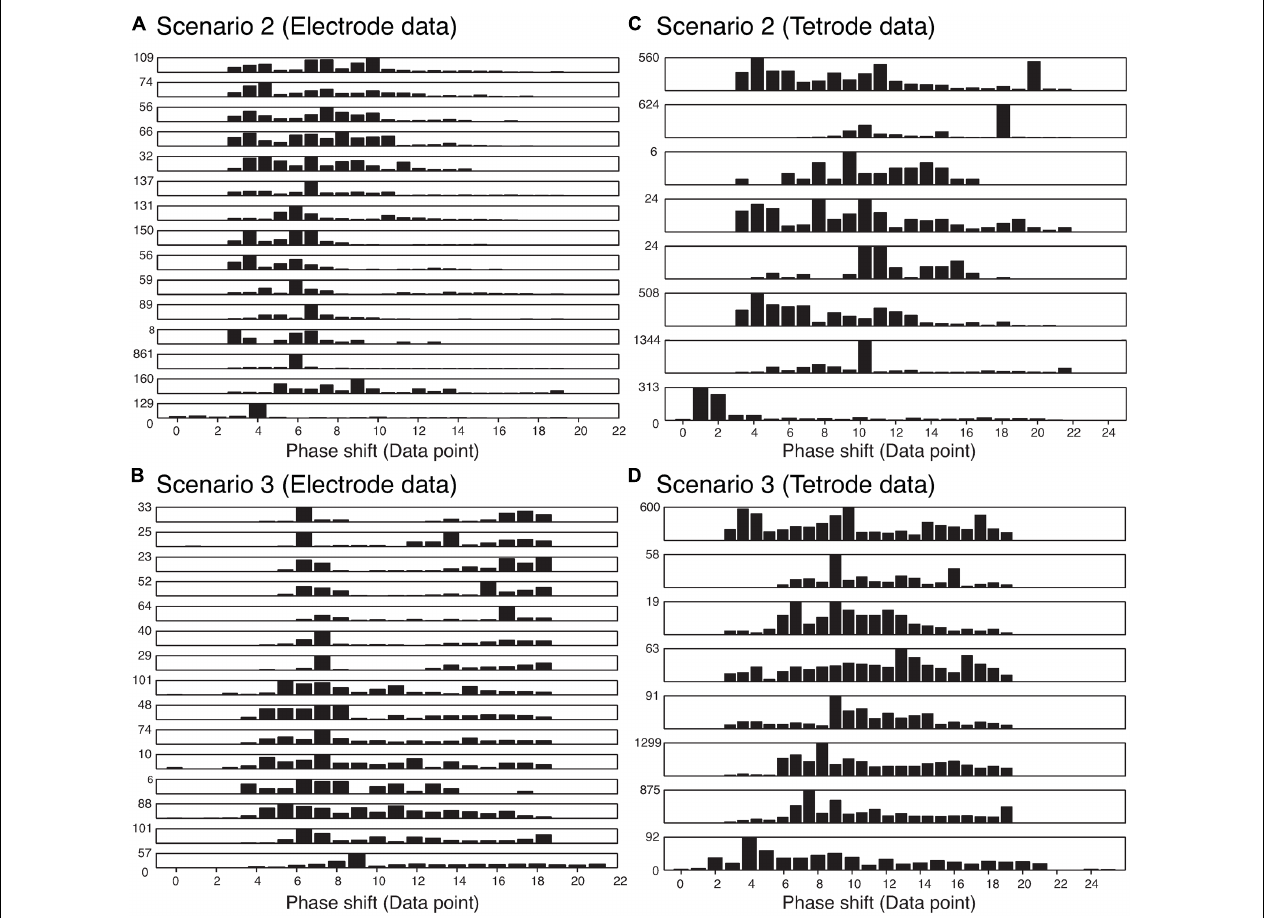
FIGURE 8 | Distribution of the absolute value of the time differences in the trigger points in the best-matching synthetic waveforms in the two assignment scenarios in the electrode and tetrode data. Each row represents a single recording. (A) Distribution of trigger point differences when only one trigger point was found in the overlapping waveform (Scenario 2) in the electrode data. (B) Distribution of trigger point differences when two trigger points were found in the overlapping waveform (Scenario 3) in the electrode data. (C) and (D) Same as (A) and (B) but for tetrode